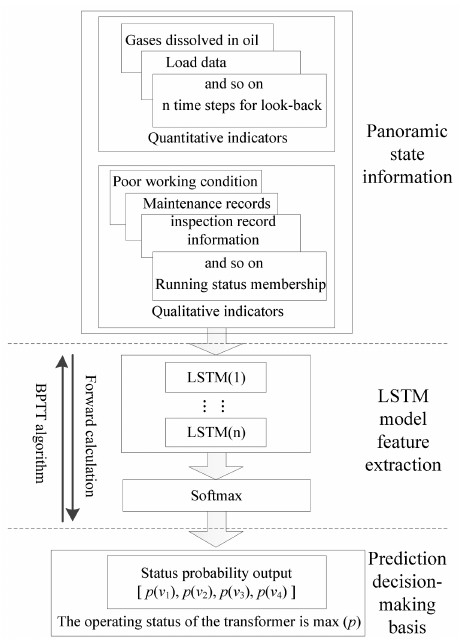
Figure 4. Transformer operating state prediction architecture based on the LSTM. BPTT: Backpropagation through